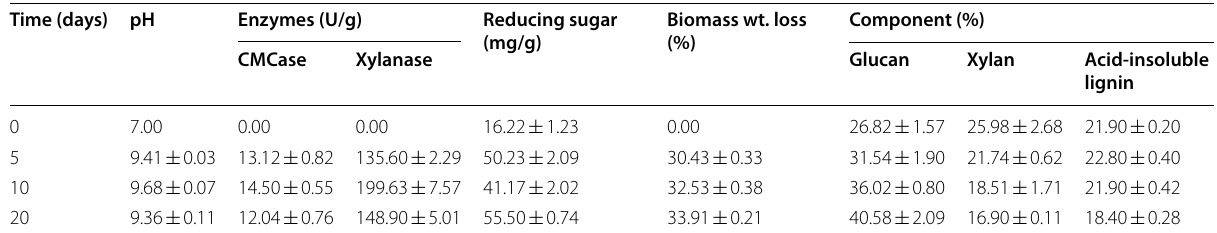
Table 1 The pH values, enzyme activities and reducing sugar yields of the supernatants, as well as the weight losses and compositions of corn stover pretreated with strain P3 for different times ( n Time (days) pH Enzymes (U/g) Reducing sugar